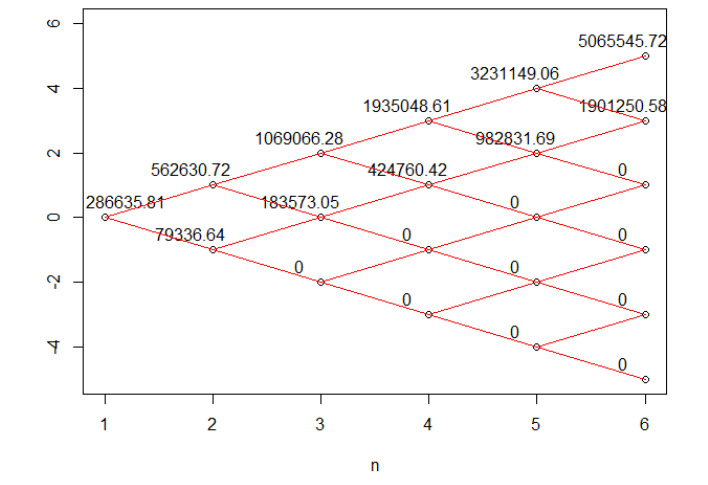
Figure 9. Tree 2 option to wait with